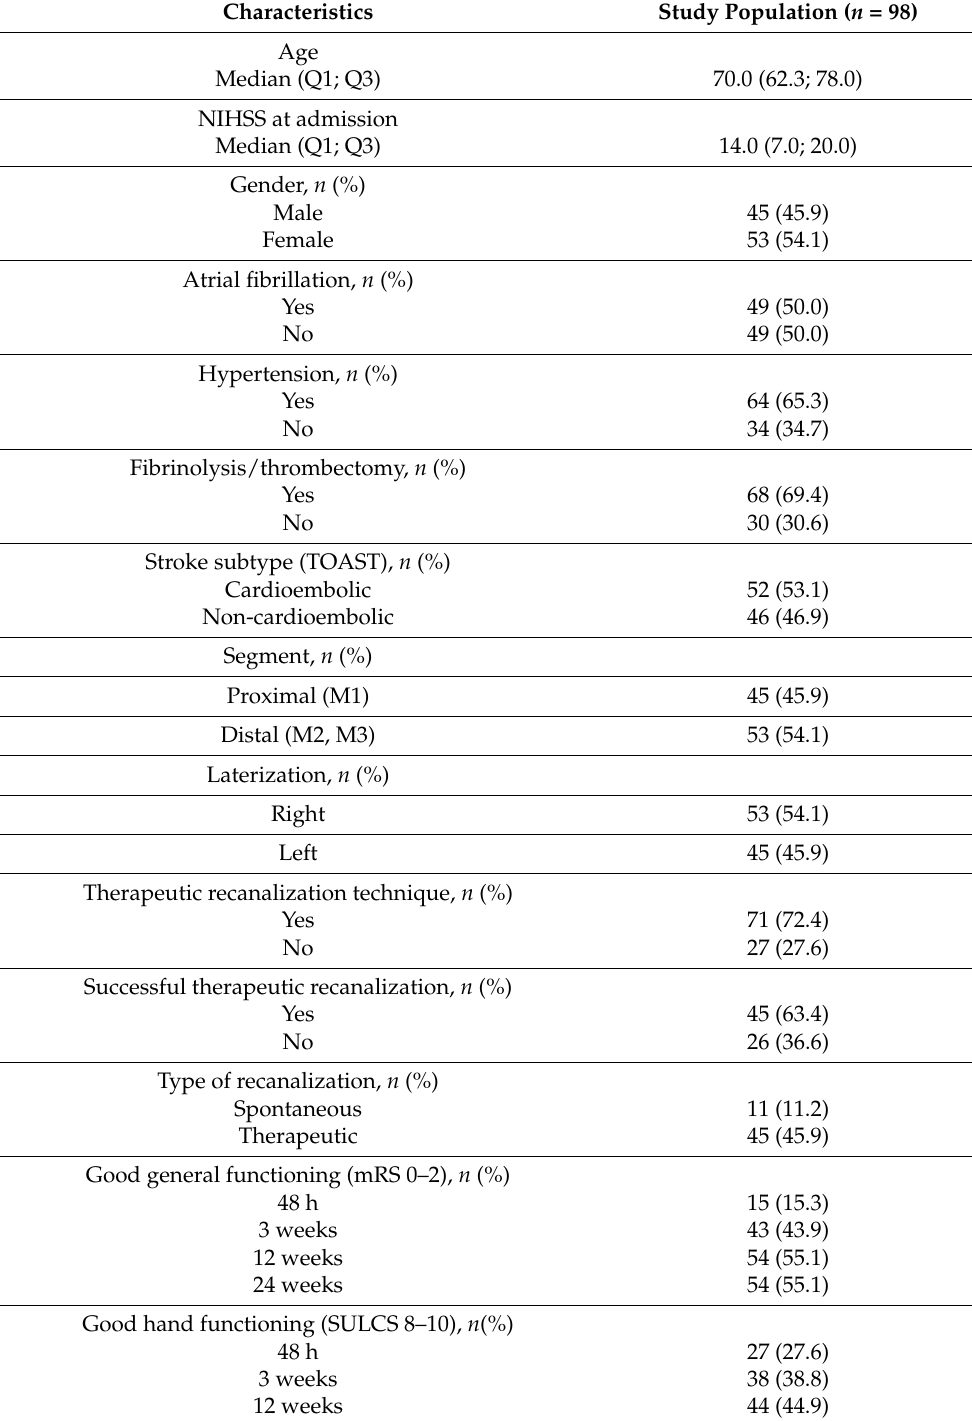
Table 1. Clinical and demographic